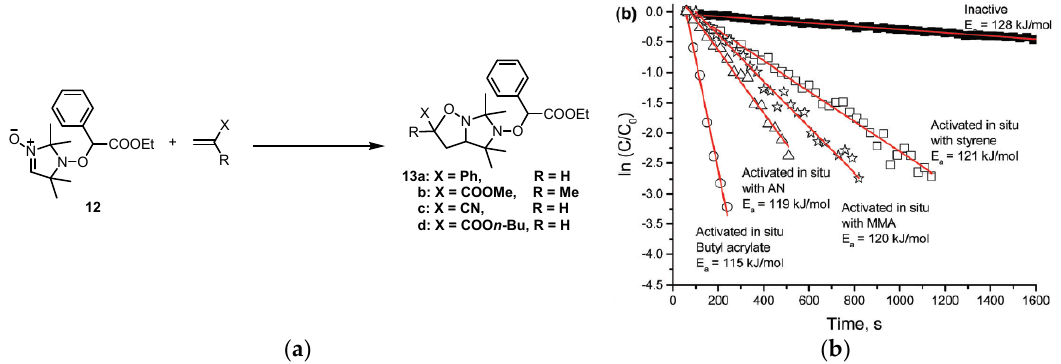
Figure 10. ( a ) Huysgen reaction between 12 and various alkenes; ( b ) E a for activation in situ by the